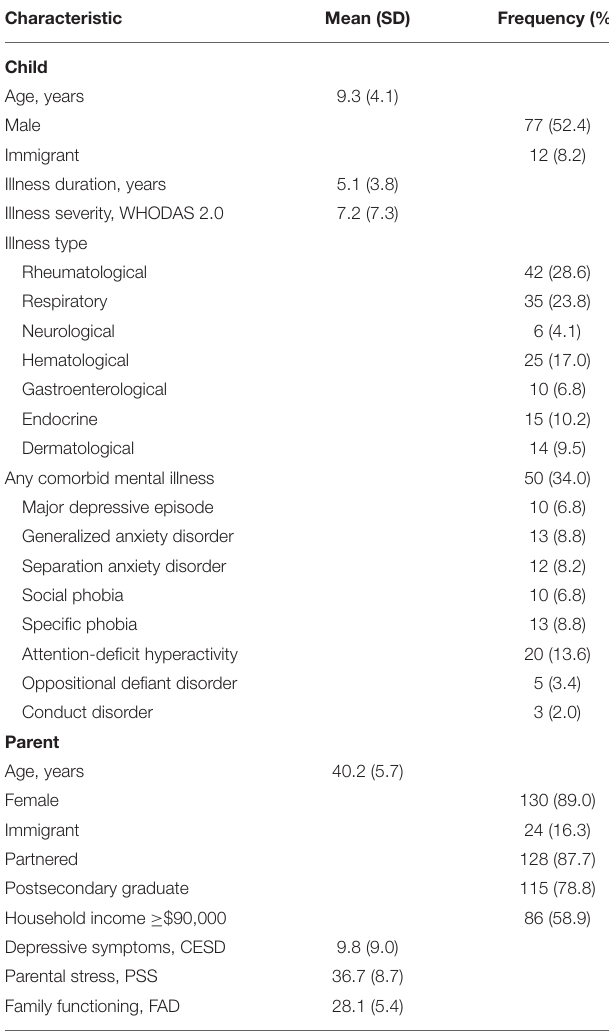
TABLE 1 | Sample characteristics at